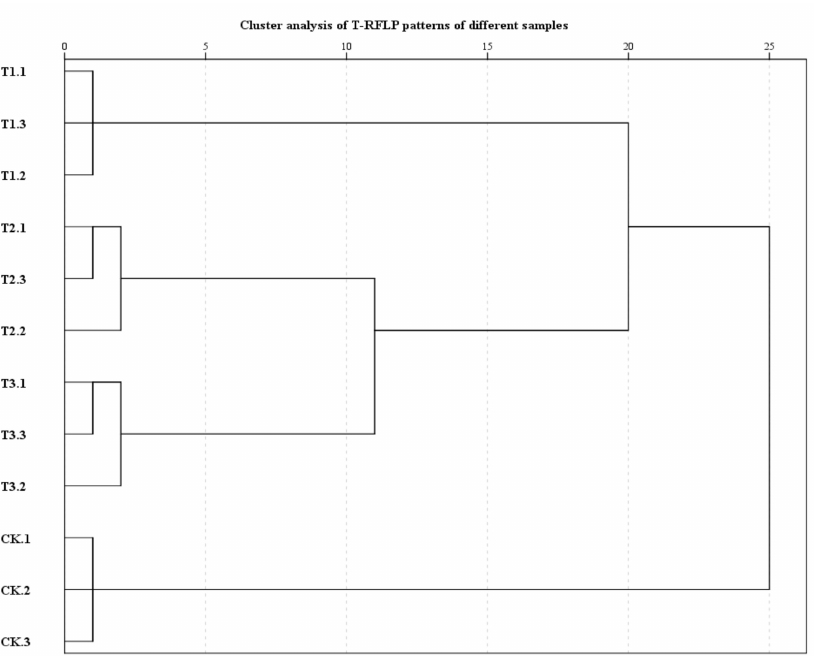
Figure 2. Cluster analysis of T-RFLP derived data for the fungal community. T1, the replanted soil fumigated with methyl bromide; T2, the replanted soil mixed cropping with A. fistulosum ; T3, the replanted soil mixed cropping with B. juncea .; CK: the replanted soil. Three replicates were calculated in every treatment.